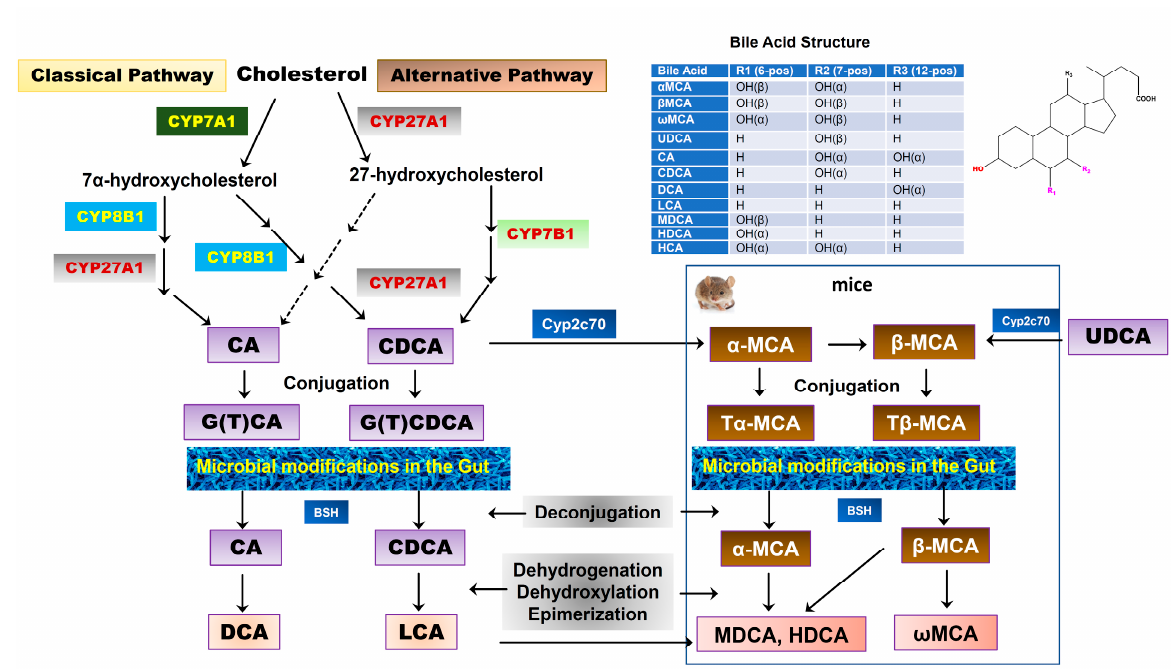
Figure 2. Bile acid synthesis in the liver and biotransformation in the gut. Two major pathways of BA synthesis from cholesterol have been characterized. Cholesterol-7 α -hydroxylase (CYP7A1) and sterol 27-hydroxylase (CYP27A1) are the rate-limiting enzymes for the classical pathway and alternative pathway, respectively. Cholic acid (CA) and chenodeoxy- cholic acid (CDCA) are two primary BAs found in humans, which are conjugated with glycine or taurine. In mice, CDCA and UDCA are further converted into α -muricholic acid ( α -MCA) and β -MCA by Cyp2c70, respectively. α -MCA also can be converted into β -MCA. Both α -MCA and β -MCA are conjugated with taurine. The conjugated primary BAs are deconjugated and transformed into secondary BAs by gut bacteria. In humans, CA is converted into deoxycholic acid (DCA) and CDCA is converted into lithocholic acid (LCA). In mice, α -MCA and β -MCA are converted into murideoxycholic acid (MDCA), hyodeoxycholic acid (HDCA), and ω -MCA. LCA also can be converted into MDCA and HDCA.